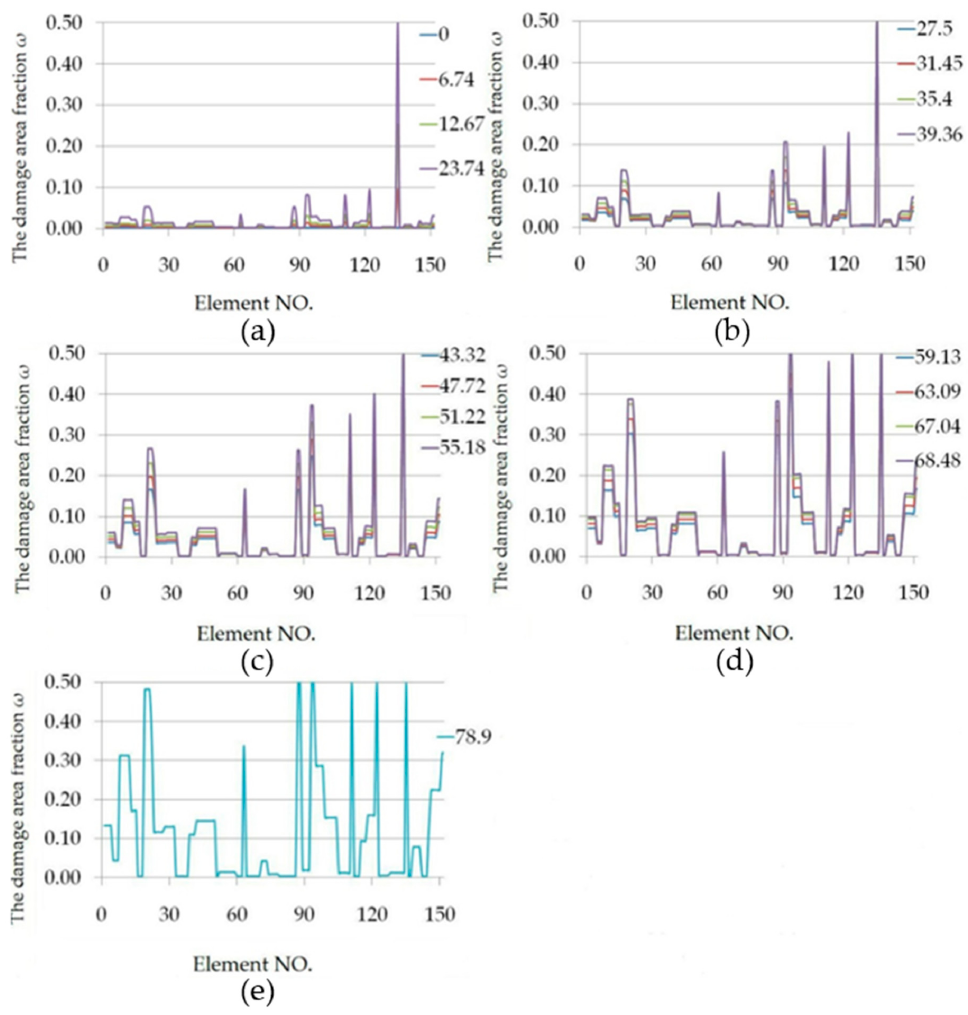
Figure 17. Damage evolution with time of the all the grain boundary elements at the same time. ( a )